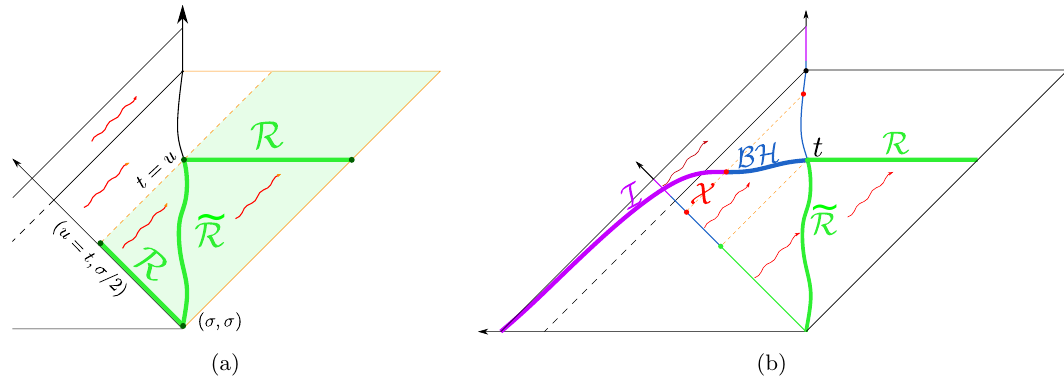
Figure 2 . (a) The radiation region R up to time t = u is shown as the (nearly) null surface in green. We can add an internal detector system where the radiation caught by the observer is stored. Every interval beginning at the left null ray and ending on the right one constitutes a correct radiation region. We can even map it into the timelike boundary interval e R . (b) Full Cauchy slice Σ = I ∪ BH ∪ R , for the case of an island outside the horizon, as we will construct. The union ˜ I ∪ BH ∪ R is not spacelike everywhere, but it serves the same goal for purely right-moving CFT matter flows as is the case